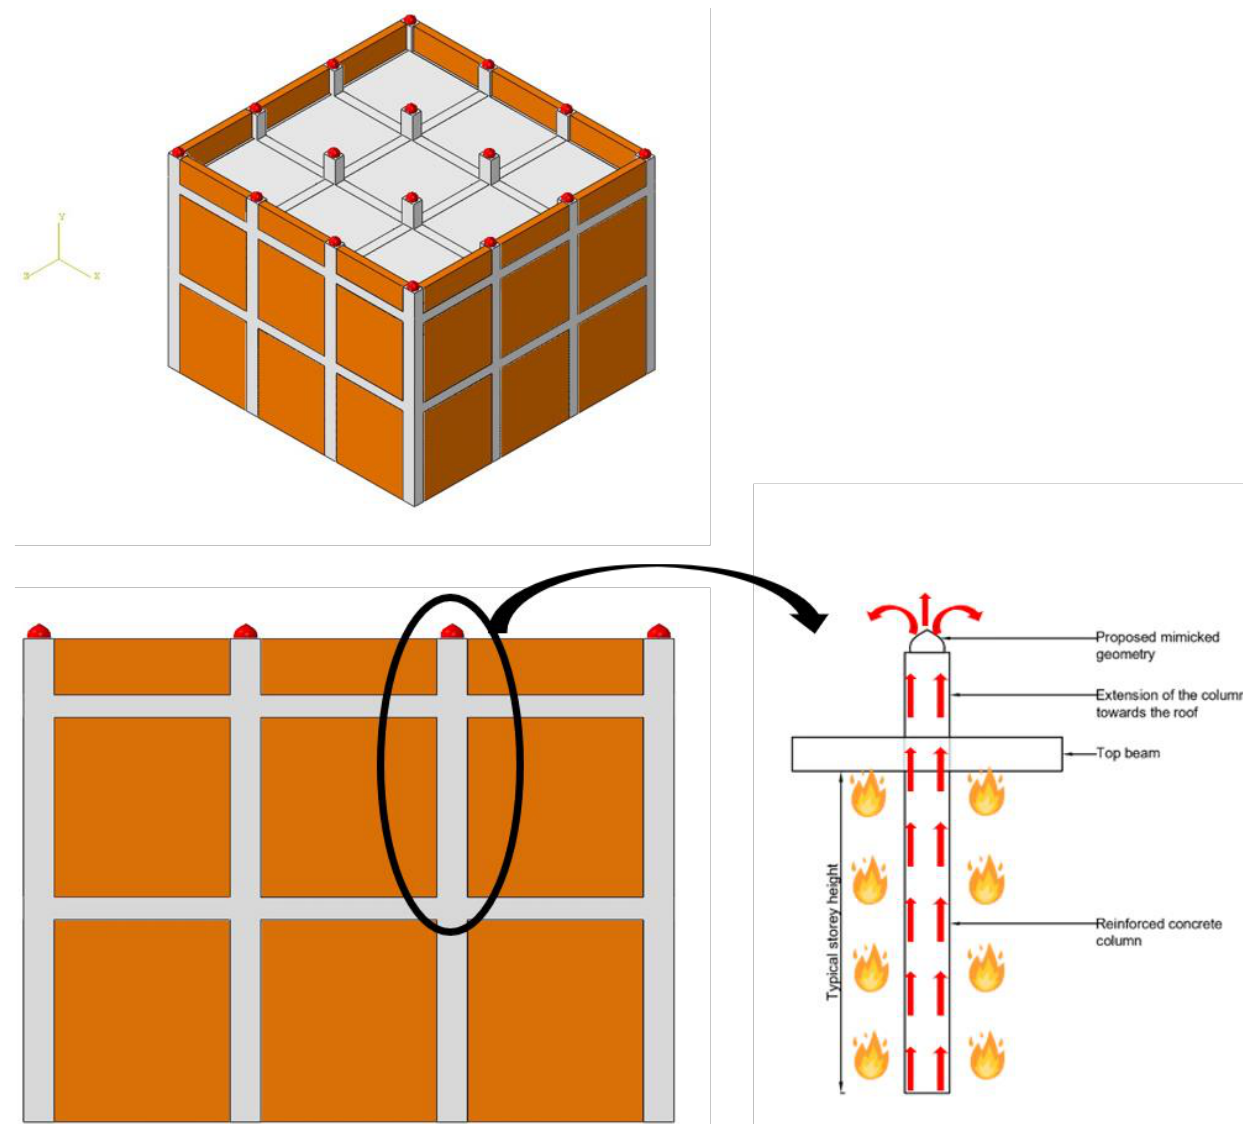
Figure 1. Representation of a biomimicked concept over the reinforced concrete column in a typical prototype building .